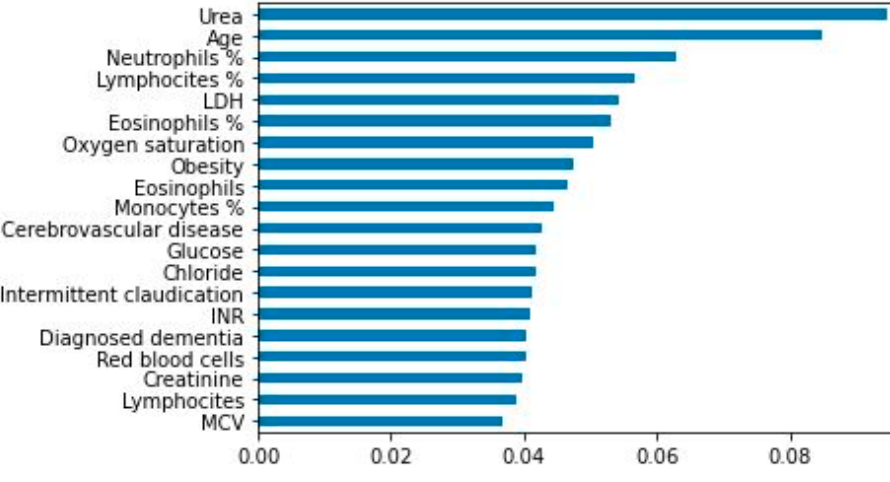
Table 4. Hyperparameter configuration of the best XGBoost models.